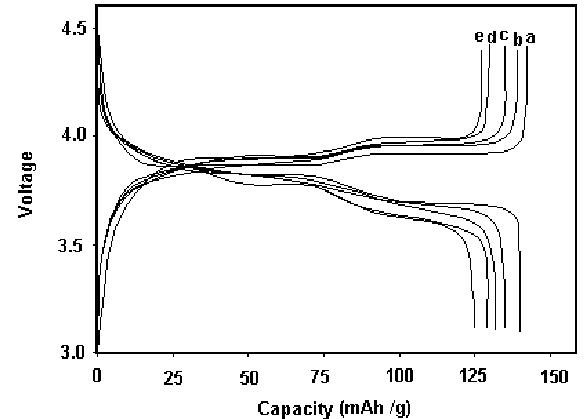
Figure 7. Charge/discharge curve of (a) LiMn 2 O 4 (b) LiNd 0.1 Mn 1.9 O 4 (c) LiNd 0.2 Mn 1.8 O 4 (d)